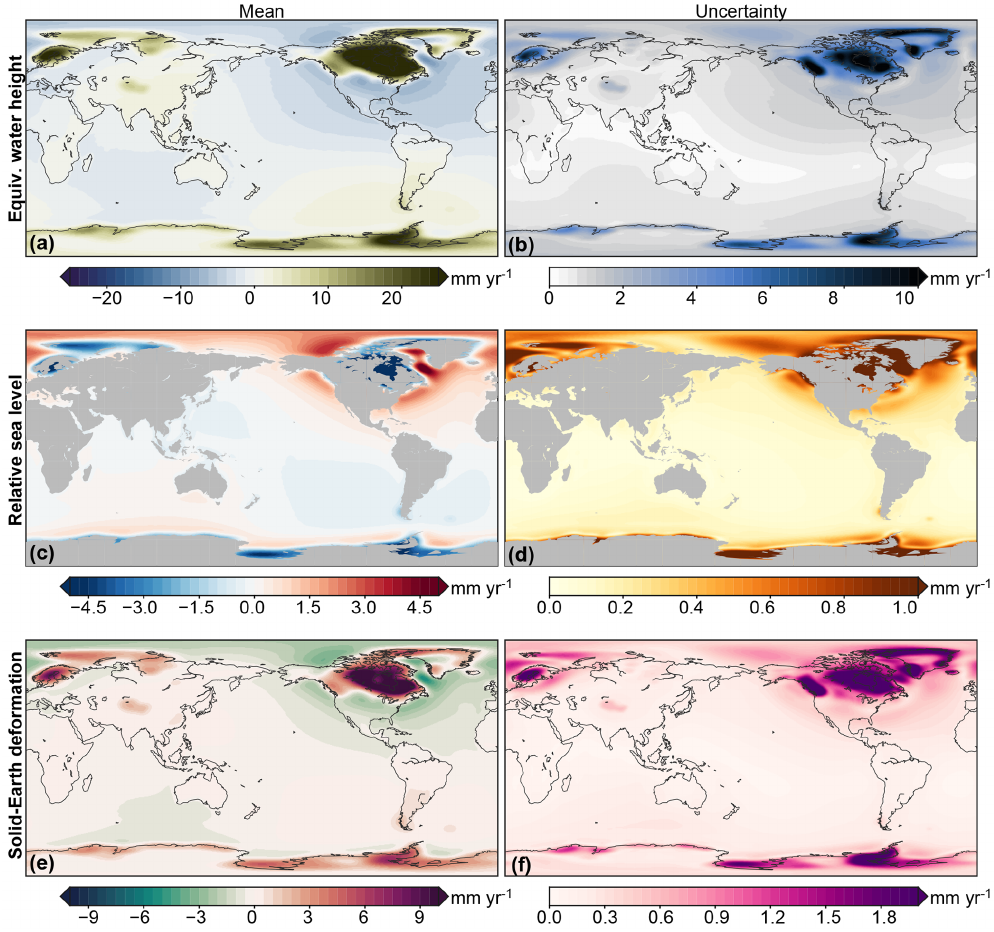
Figure 2. The effects of GIA on contemporary linear trends in EWH (a, b) , RSL (c, d) , and SED (e, f) as estimated from the 5000-member ensemble. The left panels show the ensemble mean and the right panels the 1 σ uncertainty.